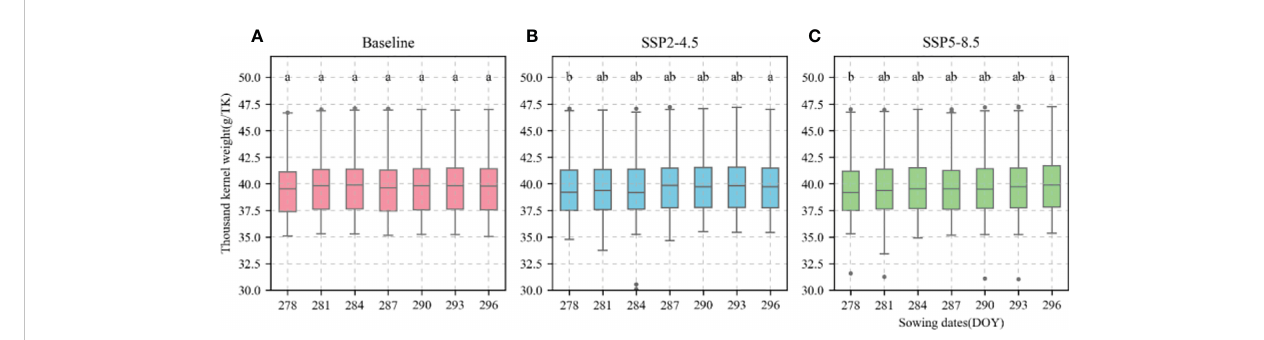
FIGURE 12 Thousand-kernel weight (TKW) of 81 wheat varieties at different sowing dates for different climate scenarios. (A) , Baseline; (B) , SSP2-4.5; (C) , SSP2- 8.5. Current sowing date (DOY 284). Different letters indicate signi fi cance at 0.05